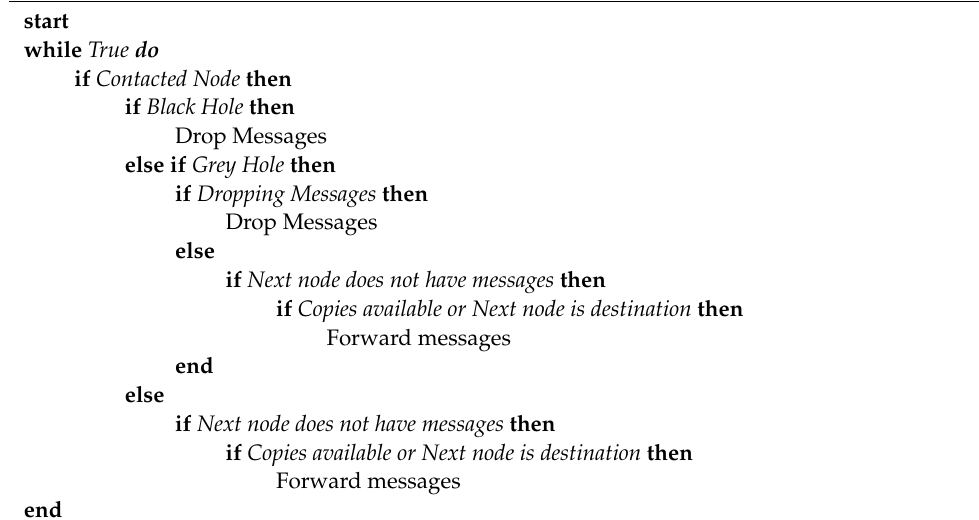
Algorithm 2. Black and Grey Hole Binary Spray and Wait